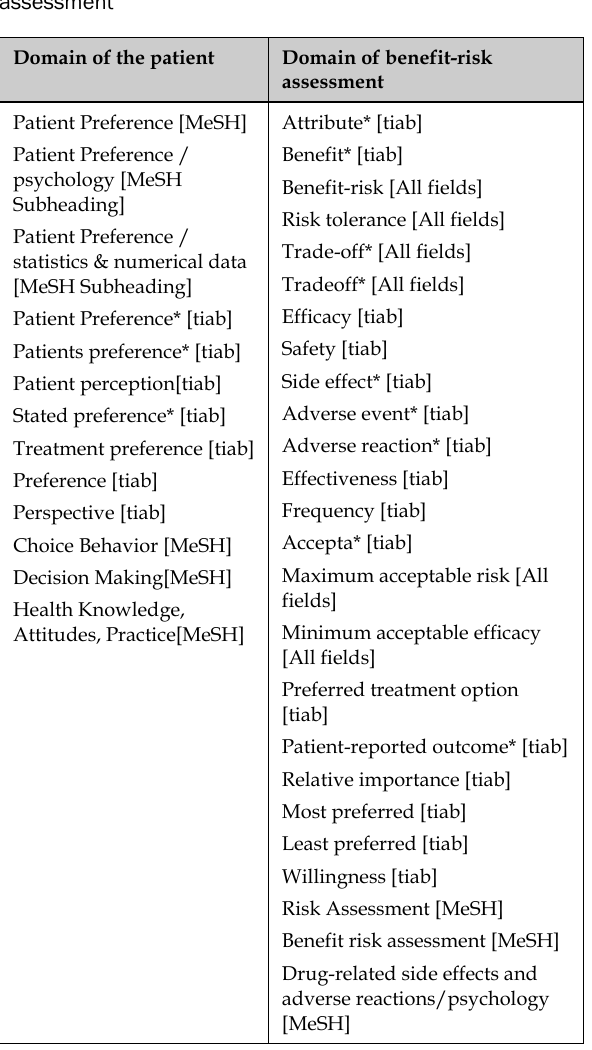
Table 2 Content search strategy of patient-based benefit-risk